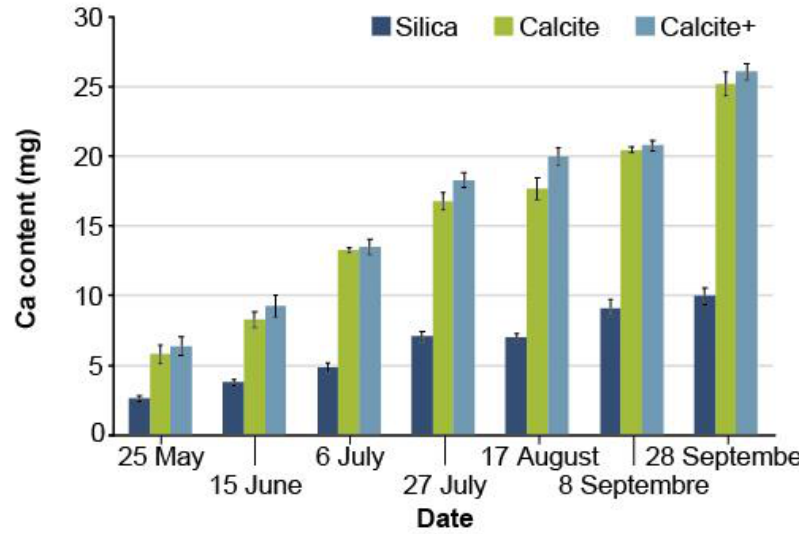
Figure 5. Evolution of the average mineral content of the shoots of white spruce seedlings (2 + 0) in calcium (Ca), depending on the treatments (silica, calcite and calcite + ) ( n = 5 composite samples of 15 plants each. The error bars represent the standard error).